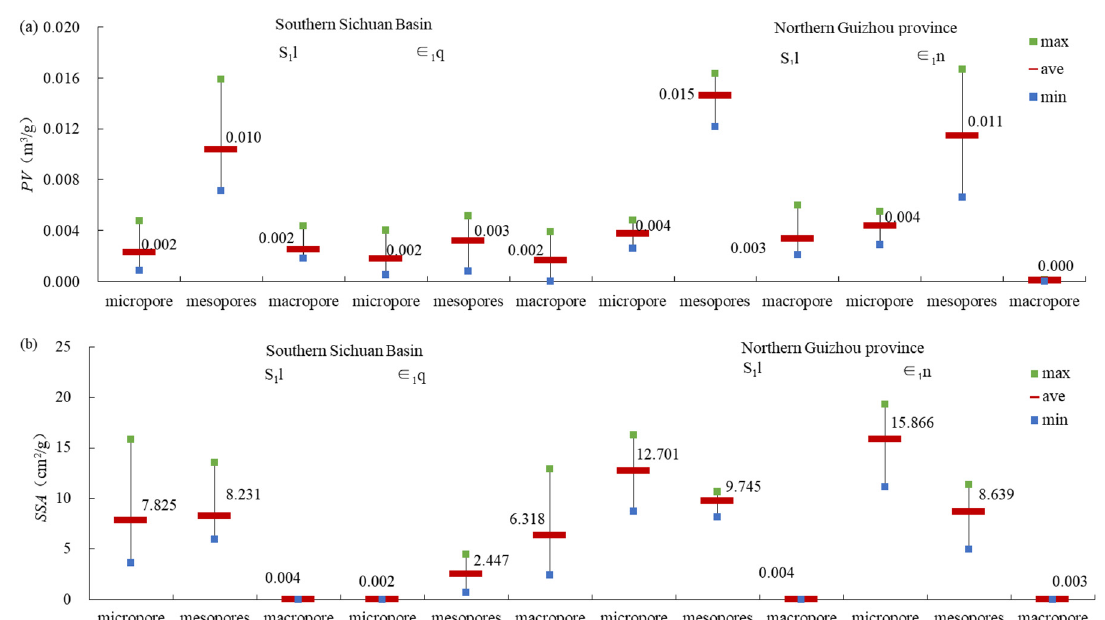
Figure 8. The distribution range graph of PV ( a ) and SSA ( b ) of the Lower Paleozoic shales in the upper Yangtze plate.